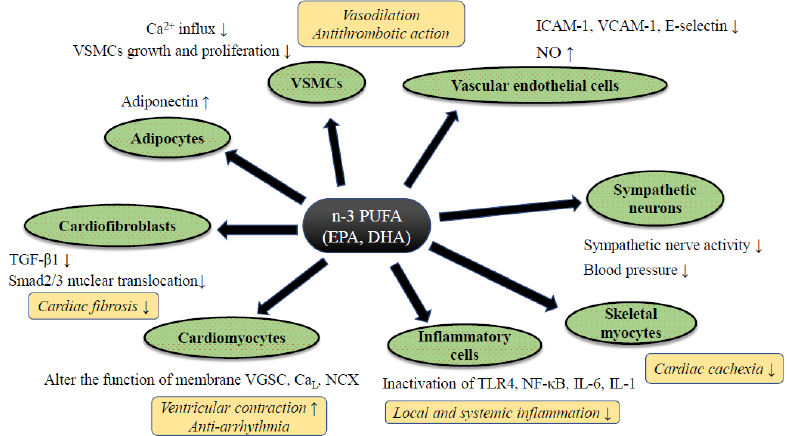
Figure 2. The putative mechanism of n-3 PUFA-mediated cardiac protection against heart failure. Abbreviations: Ca L ; L type calcium channel, IL-6/-1; ICAM-1; intercellular adhesion molecule-1, Interleukin-6/-1, NCX: sodium calcium exchanger, NF- κ B; nuclear factor-kappa B, NO; nitric oxide, TGF- β 1; transforming growth factor-beta 1, TLR4; Toll-like receptor 4, VGSC; voltage-gated sodium channel, VCAM-1; vascular cell adhesion molecule-1, VSMCs; vascular smooth muscle cells. Abbreviations: ADMA: Asymmetric Dimethylarginine, DB: Double blind trial, ESLVD: End-systolic left ventricle diameters, Etv/Atv: Early rapid right ventricular filling/late right ventricular filling, FMD: Flow-mediated dilatation, LAEF: Left atrial ejection fraction, LVESVI: Left ventricular